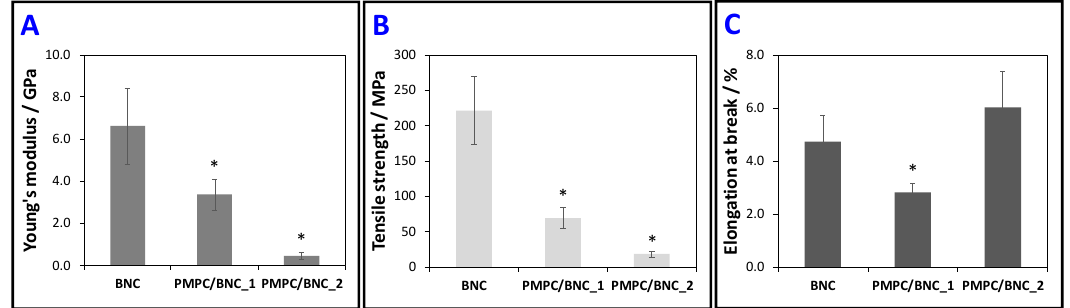
Figure 7. ( A ) Young’s modulus, ( B ) tensile strength and ( C ) elongation at break of neat BNC and PMPC/BNC nanocomposites; the error bars correspond to the standard deviations; the asterisk (*) denotes statistically significant differences with respect to the neat BNC ( p < 0.05).